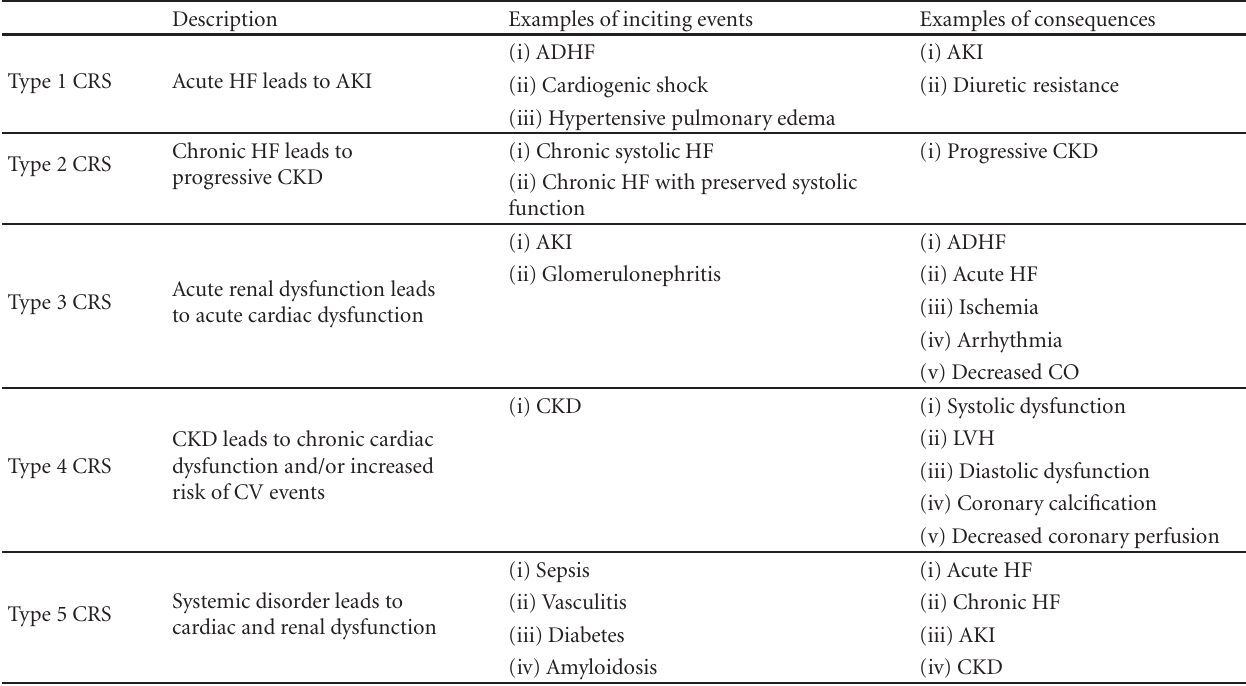
Table 1: Classification system of cardiorenal syndrome